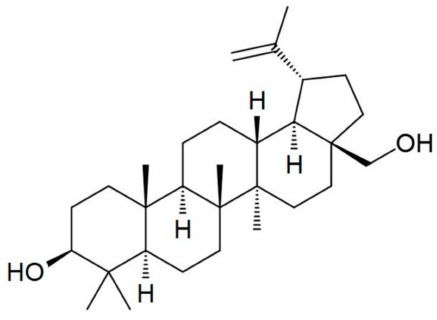
Figure 1. Chemical structure of